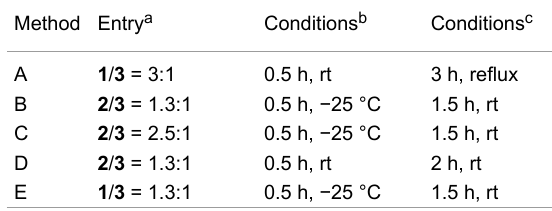
Table 1: Reaction conditions for the Grignard reaction. Method Entry